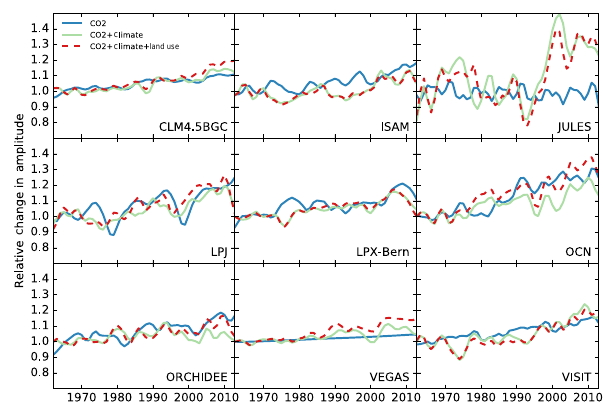
Figure 7. Trends for seasonal amplitude of global total net carbon fluxes from S1 (CO 2 ) , S2 (CO 2 + climate) and S3 (CO 2 + climate + land use) for each individual TRENDY model. All amplitude time series are relative to their own 1961–1970 mean am-